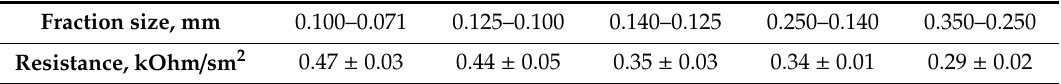
Table 6. Dependence of the resistance of the sample on the size of the xerogel